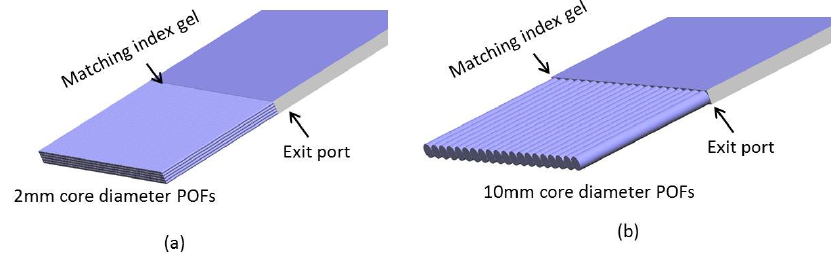
Figure 5. Illustration for a piece of stepped ‐ thickness waveguide coupled with the ribbon arrangement of ( a ) 2 mm core diameter POFs; and ( b ) 10 mm core diameter POFs.